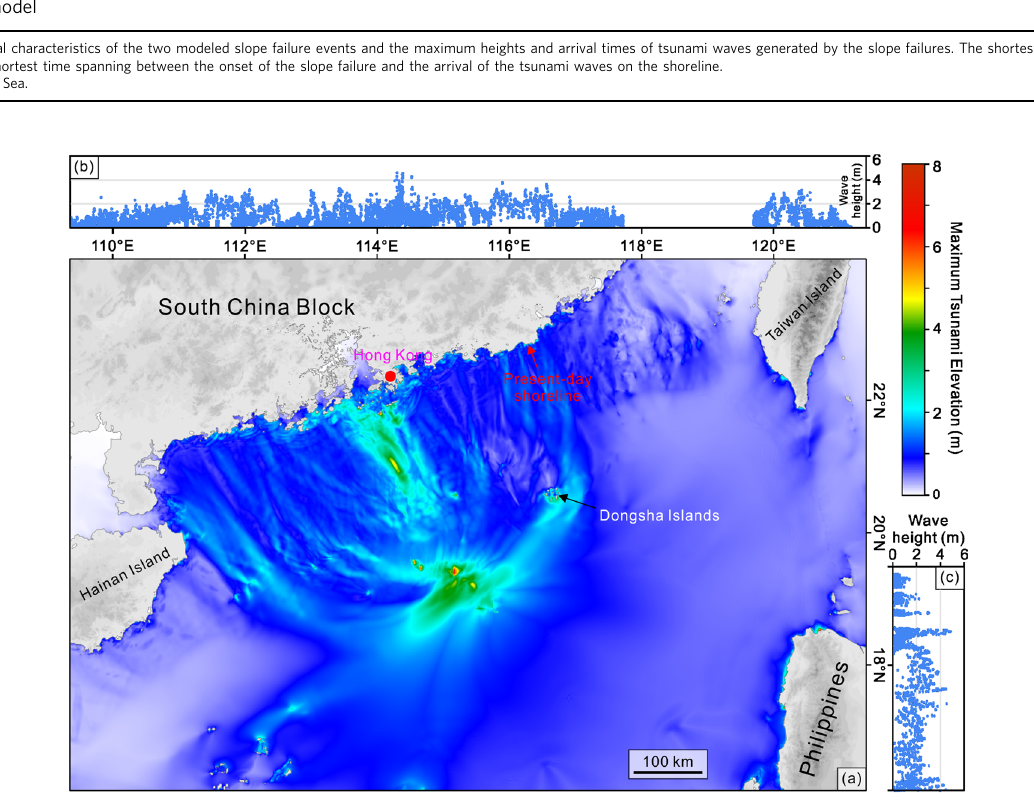
Fig. 7 Maximum tsunami-wave height generated by the present-day bathymetric conditions and shoreline position. a Maximum tsunami-wave height generated by a submarine landslide considering the present-day bathymetry and shoreline position. b Tsunami-wave height along the shoreline of the northern South China Sea reaches a maximum of ~5 m. c Tsunami-wave height along the shoreline of the eastern South China Sea also reaches a maximum of ~5